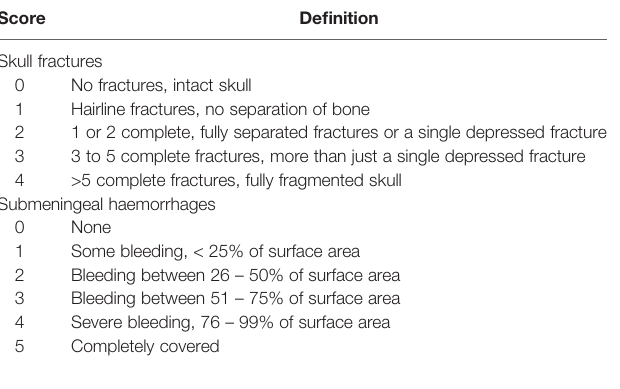
TABLE 3 | Scoring system for evaluating the severity of skull fractures (from 0 to 4) and submeningeal haemorrhages (from 0 to 5) after killing with captive bolt method (adapted from Veltri and Klem, 2005 and Erasmus et al.,